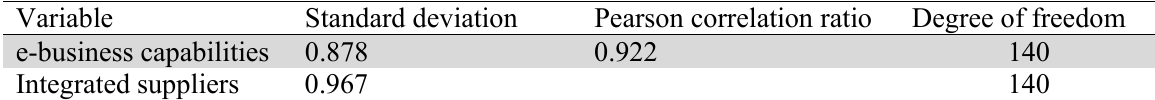
Pearson correlation test between e-business and integrated supplier Variable